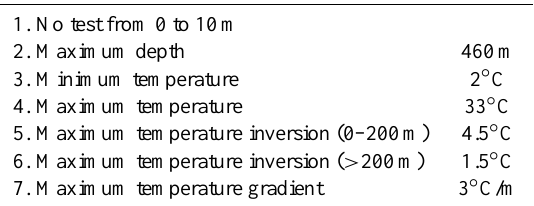
Table 2. Gross range check applied by the Argos software before decimation and